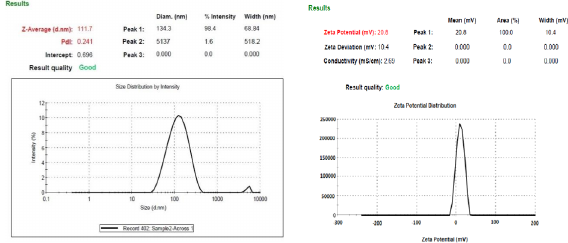
Figure 3. Zeta-potential Distribution of Chitosan Nanoparticles